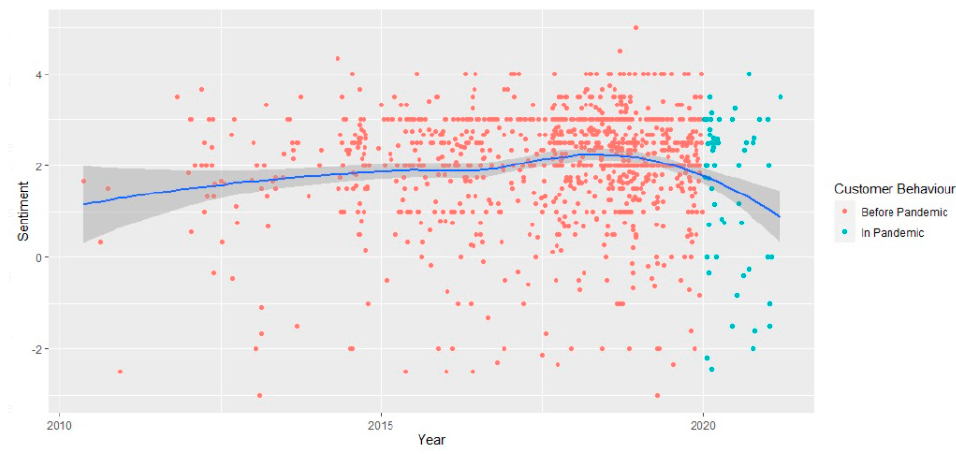
Figure 6. The customer sentiment score over time.